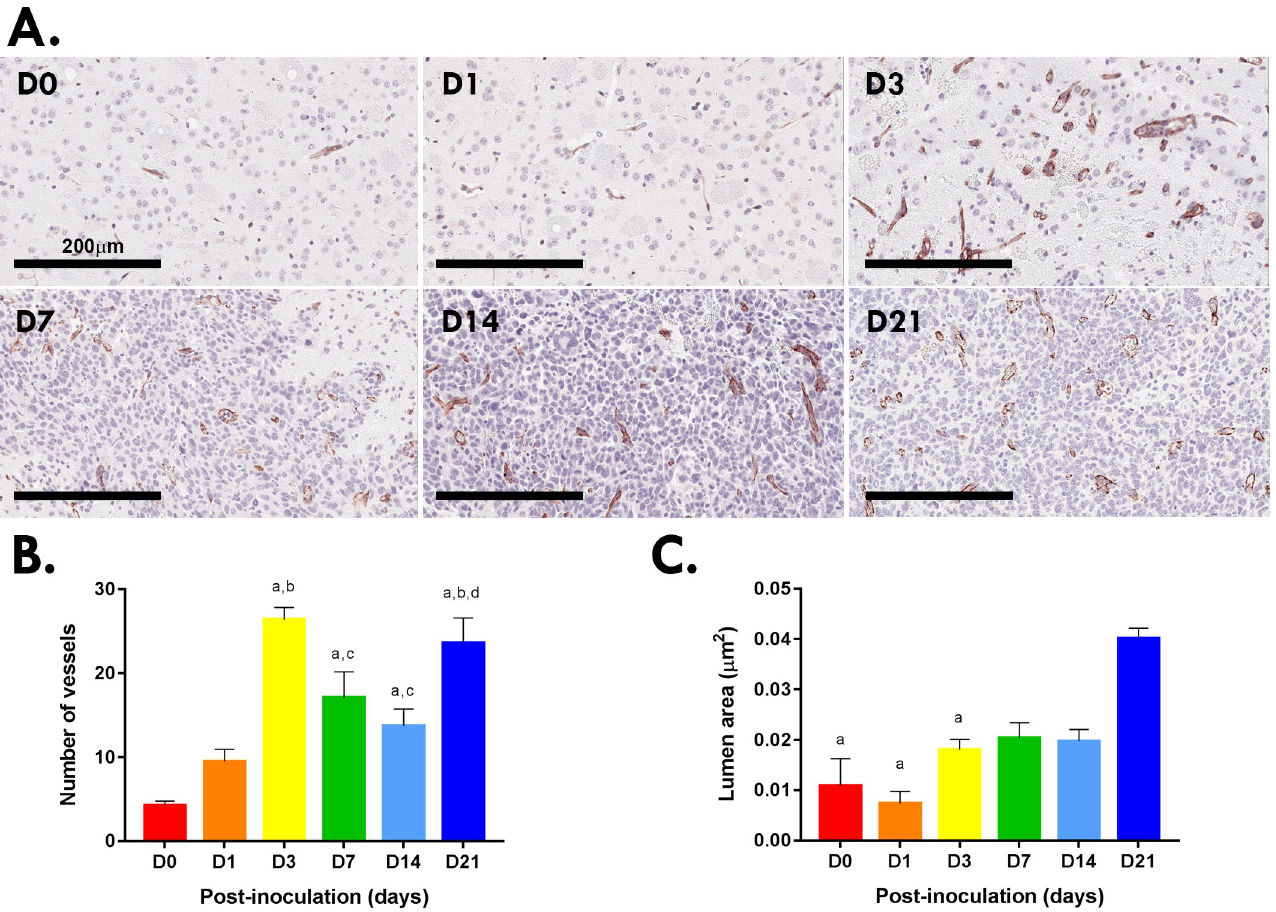
Fig 4. Number of blood vessels in Gl261 gliomas. CD31 + blood vessels at the inoculation site of murine Gl261 gliomas (A). Scale bar, 200 μ m. Quantitation of blood vessels (B) and lumen area (C) in five HPF (20x) for each murine brain (N = 12 brains per time point; B). Data are expressed as mean ± SEM per HPF. (B) a p < 0.05 vs D0, b p < 0.05 vs D1, c p < 0.05 vs D3, d p < 0.05 vs D14 by Tukey’s multiple comparison test. (C) a p < 0.05 vs 21 by Tukey’s multiple comparison test.